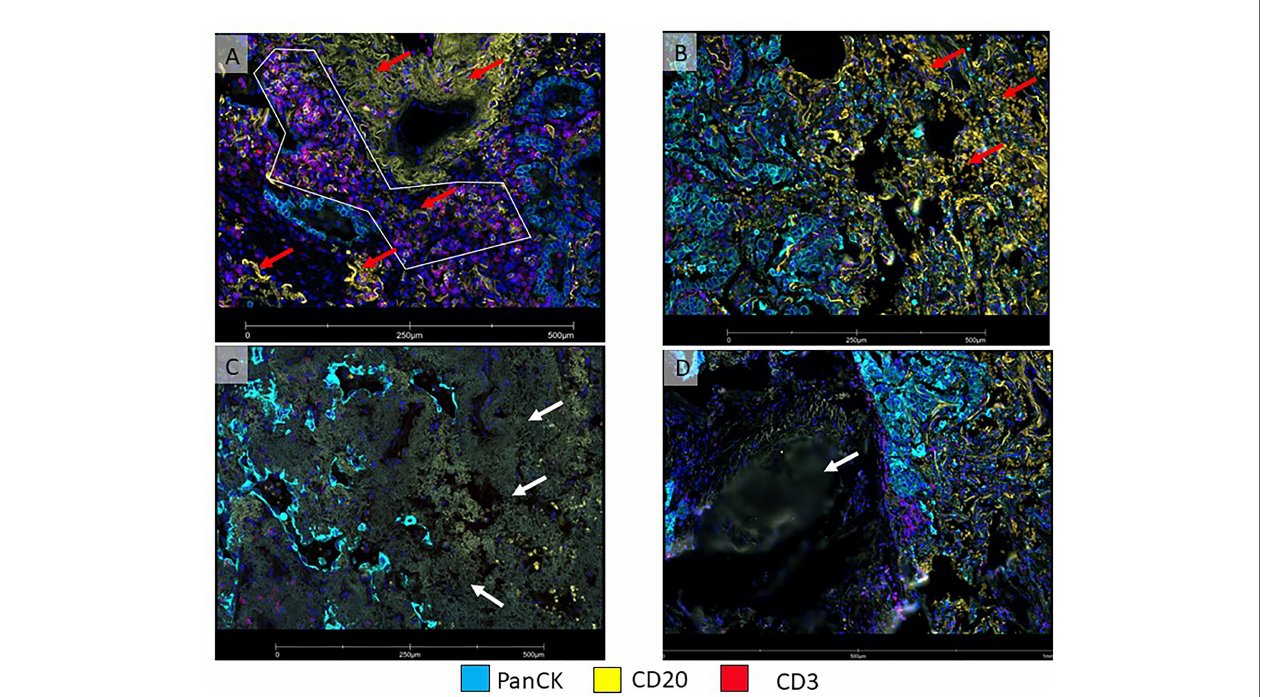
FIGURE 4 | Micro photographs showing artifacts in immuno fl uorescence DSP slide from a non-small cell lung carcinoma tumor sample (A) ROI was drawn with a polygon ROI, avoiding elastic fi bers (red arrows) that emit non-speci fi c fl uorescence signal (yellow), (B) Area on the right (red arrows) show numerous red blood cells emitting non-speci fi c fl uorescence signal (yellow). Both, elastic fi bers and red blood cells, interfered with segmentation for B-cells. (C) Tumor area on the left shows fi brosis with non-speci fi c fl uorescent signals (white arrow). (D) An area out of focus (white arrow) is observed on the left side of the